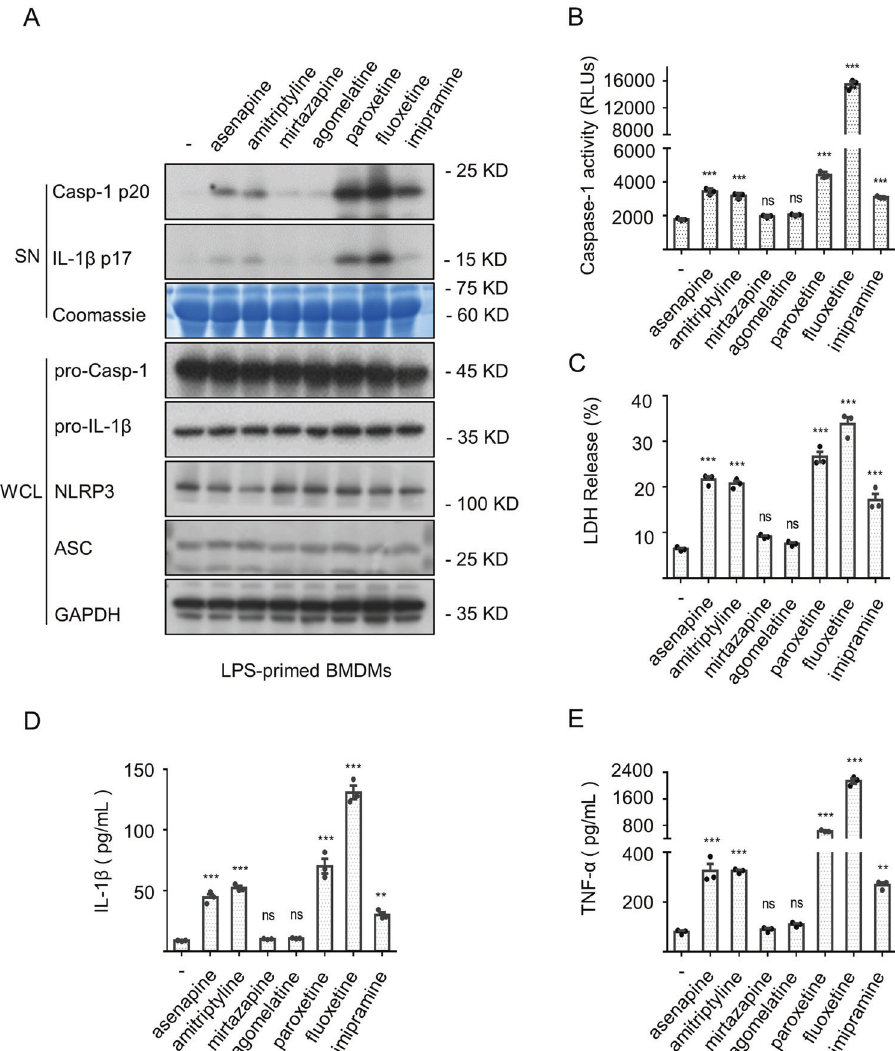
activity ( B ) and the release of LDH ( C ) in SN were detected. The secretion of IL-1 β ( D ) or accumulation of TNF- α ( E ) was detected by ELISA. Data are represented as the mean ± SEM from three biological samples, *P < 0.05, **P < 0.01, ***P < 0.001 vs . the control. One-Way ANOVA analysis was followed by Dunnett ’ s post-hoc test (ns, not signi fi